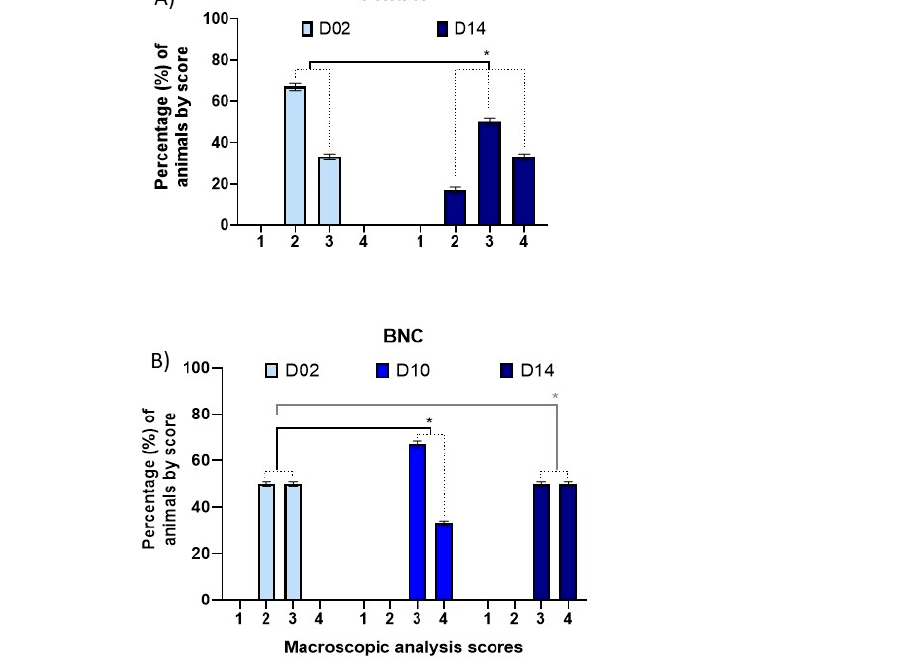
Figure 2. Influence of time for intragroup analysis of healing process ( n = 12). Macroscopic evaluation of surgical wounds of animals from Experiment I. In ( A ) Control group = standard treatment (antisepsis with topical PVPI solution followed by larvicidal repellent); comparison of data between days 2 and 14; * p < 0.05. In ( B ) BNC group = standard treatment + bacterial nanocellulose membrane; comparison of data among days 2, 10 and 14; * p < 0.05.